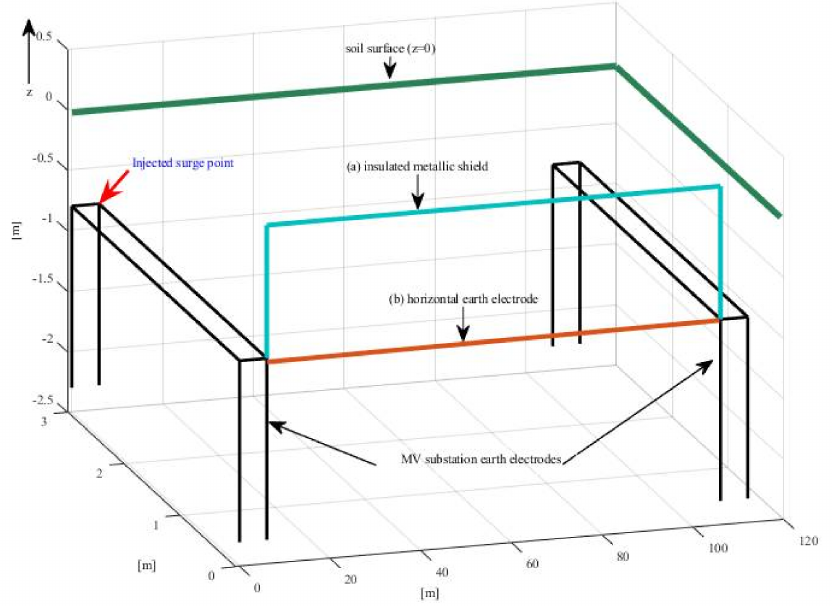
Figure 2. Scenario 1—Direct lightning stroke to an MV/LV substation in an MV line. ( a ) Interconnection realized by insulated metal shields; ( b ) Interconnection by a horizontal earth electrode.